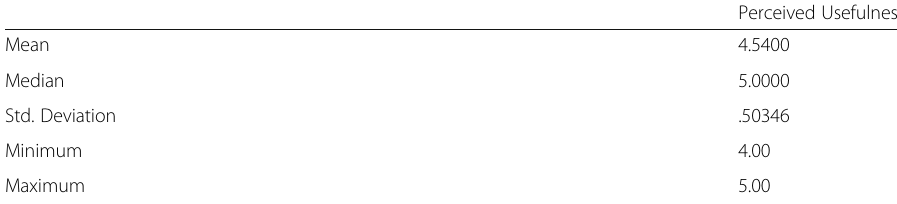
Table 7 Analysis for perceived